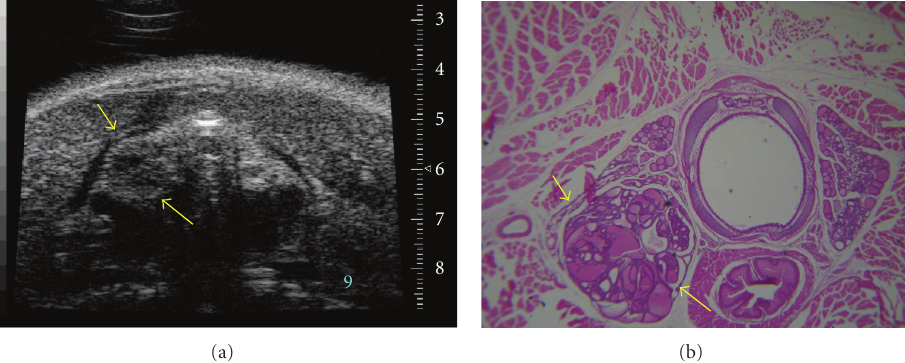
Figure 8: (a) UBM microimaging of thyroid in living mice performed with a 35 MHz probe in a genetically engineered mice model of thyroid disease (TRK). The figure shows an enlarged left lobe with hypoechoic nodule (arrows). (b) Histopathology analysis shows a thyroid adenoma. From Mancini et al. Endocrinology [2].